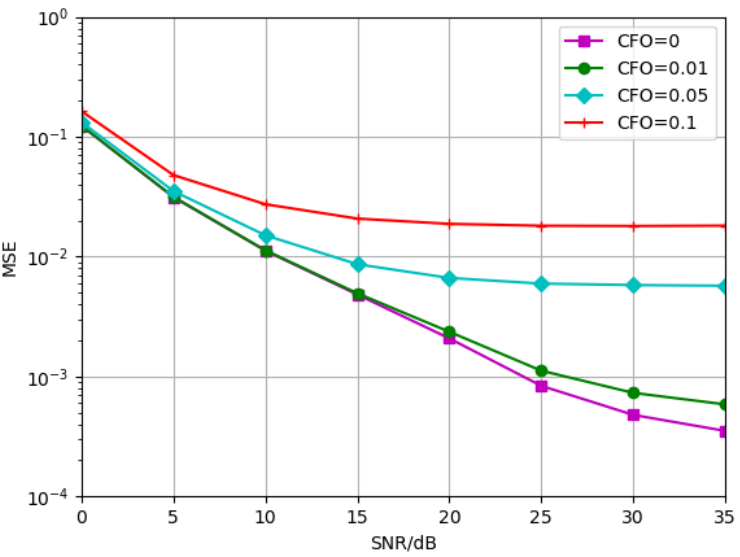
Figure 15. Generalization performance of NDR-Net trained at CFO = 0 and tested under the condi- tions of CFO = 0, 0.01, 0.05, 0.1, respectively.